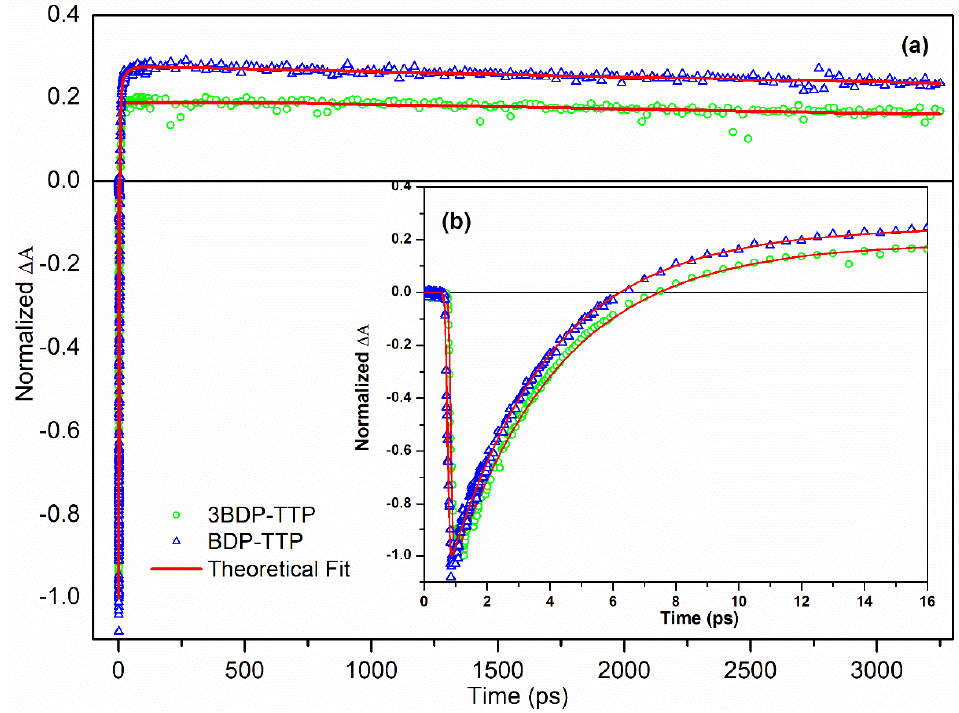
Figure 7. ( a )Decay kinetics of BDP –– TTP and 3BDP –– TTP at 524 nm probe wavelength. ( b )The inset represents zoomed Figure 7. ( a ) Decay kinetics of BDP-TTP and 3BDP-TTP at 524 nm probe wavelength. ( b ) The inset decay traces between a 0 and 16 ps timescale. represents zoomed decay traces between a 0 and 16 ps